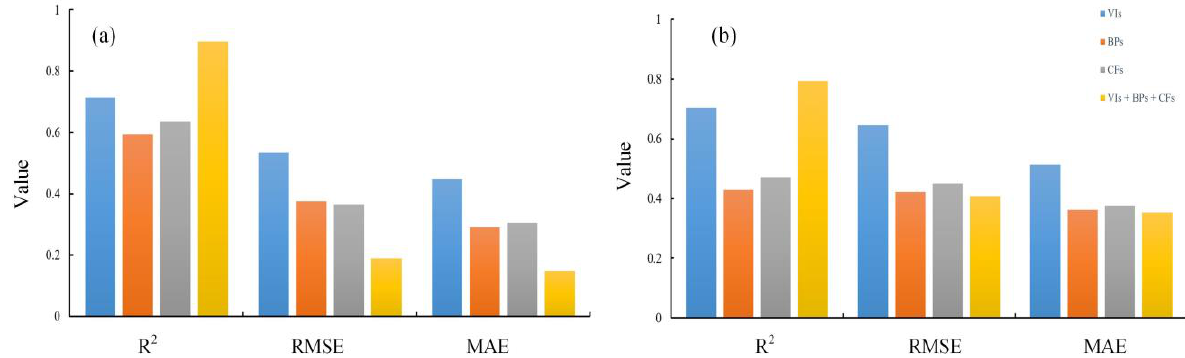
Figure 9. Estimation results of PSO-SVR with different datasets, including ( a ) calibration set, ( b ) validation set.